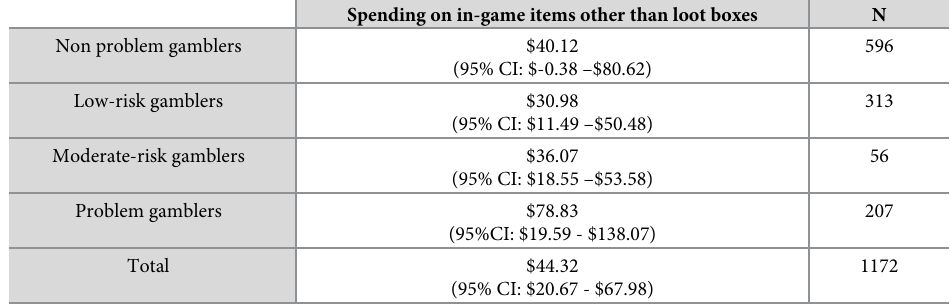
Table 3. Means and 95% confidence intervals for player spending on other in-game items, split by problem gam- bling severity. Spending on in-game items other than loot boxes